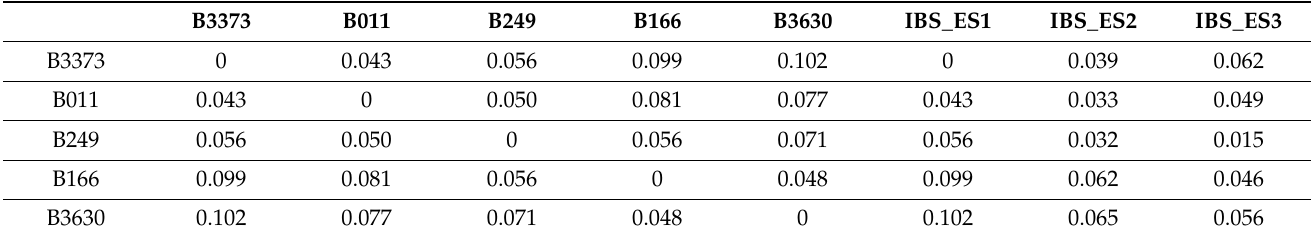
Table 5. A matrix of Jensen–Shannon Distances between basaltic soil distributions.